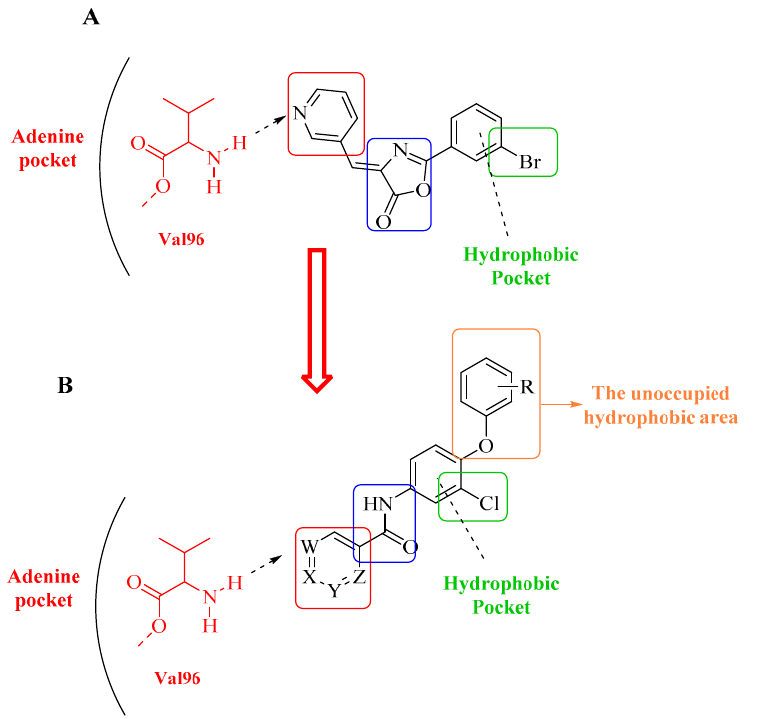
Figure 2. Diagrammatic representation of the structural modifications of compound III for developing new DAPK inhibitor candidates: ( A ) molecular interactions of compound III into the DAPK active site; ( B ) proposed binding interaction of the new synthesized derivatives 4a ‒ r into the DAPK kinase domain (W, X, Y, and Z could be C or N atoms).